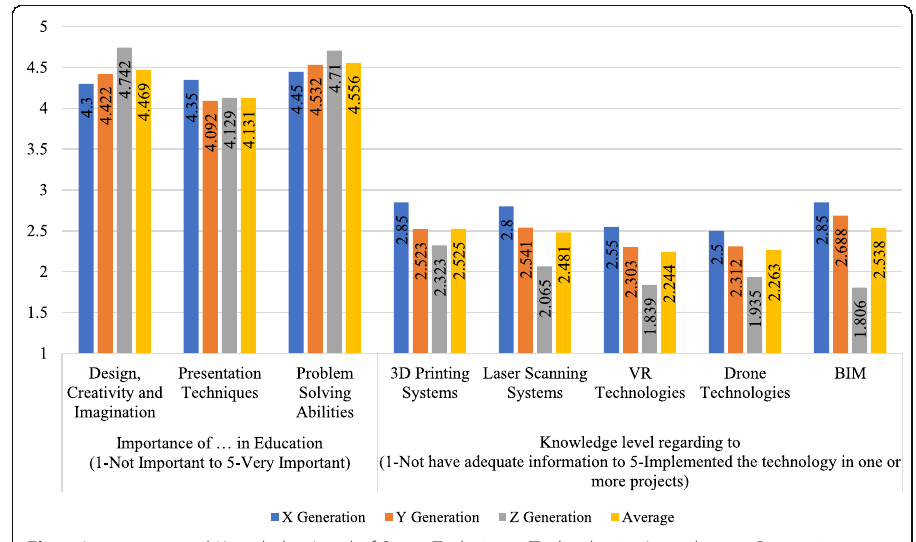
Fig. 1 Importance and Knowledge Level of Some Techniques/Technologies According to